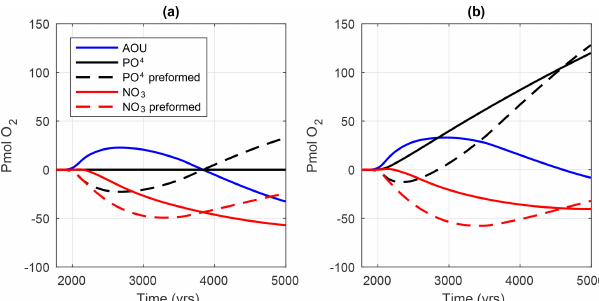
Figure 10. Anomalies of globally integrated AOU (blue line), PO 3 − (solid black line), preformed PO 3 − (dashed black line), NO − 4 4 3 (solid red line) and preformed NO − (dashed red line) expressed 3 in Pmol O 2 equivalents using constant elemental ratios (O:N = 10 and O:P = 160) for the (a) Ref simulation and the (b) Weath0.15 simulation. Preformed nutrients are calculated as the difference be- tween remineralized and total nutrient content. The calculations as- sume that all ocean water leaves the surface layer saturated in O 2